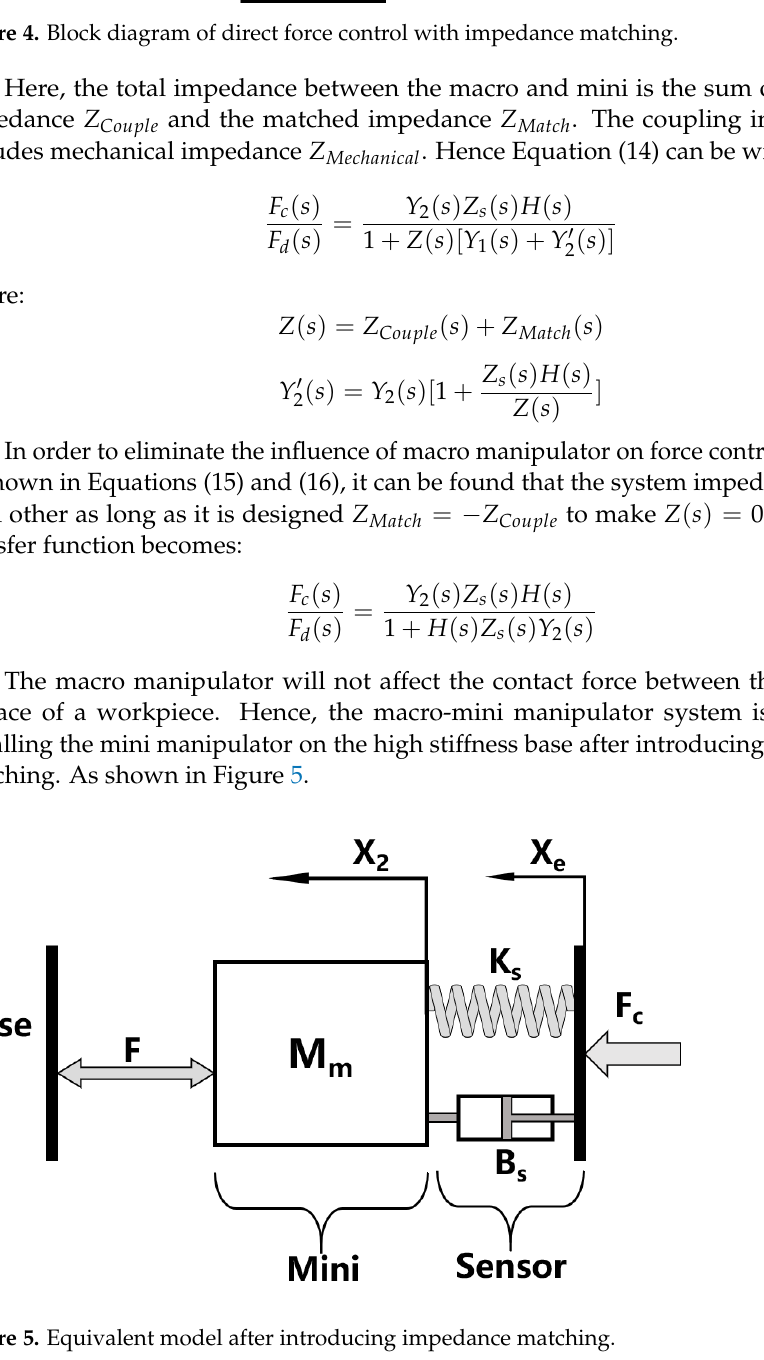
Figure 5. Equivalent model after introducing impedance